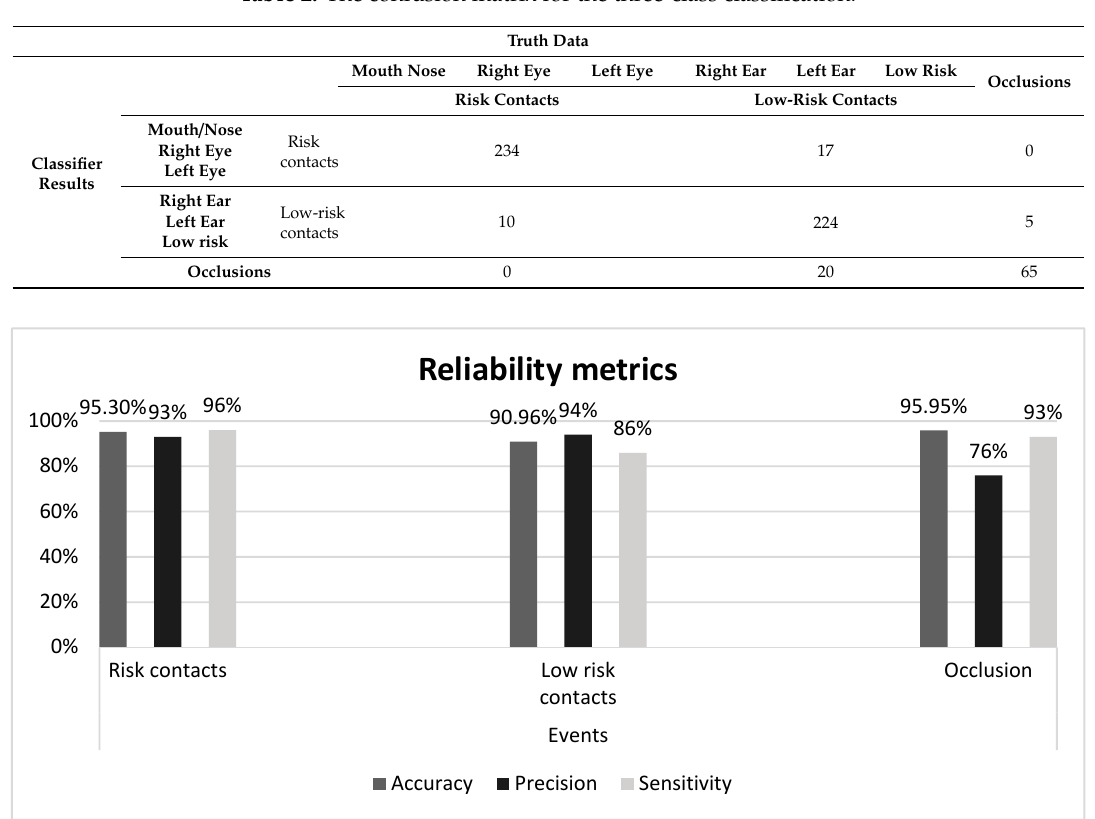
Table 2. The confusion matrix for the three-class classification.